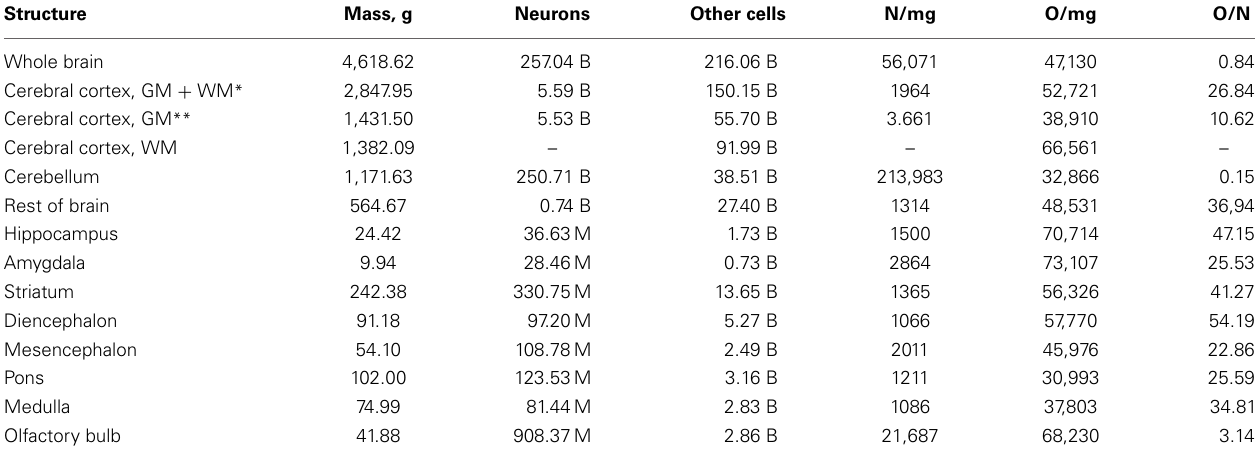
All figures refer to 2 times the values obtained for one half-brain. N/mg, density of neurons per milligram of tissue. O/mg, density of other (non-neuronal) cells per milligram of tissue. B, billion cells (1 × 10 9 ). M, million cells (1 × 10 6 ). GM, gray matter. WM, white matter. * , includes hippocampus and amygdala. ** , excludes hippocampus and